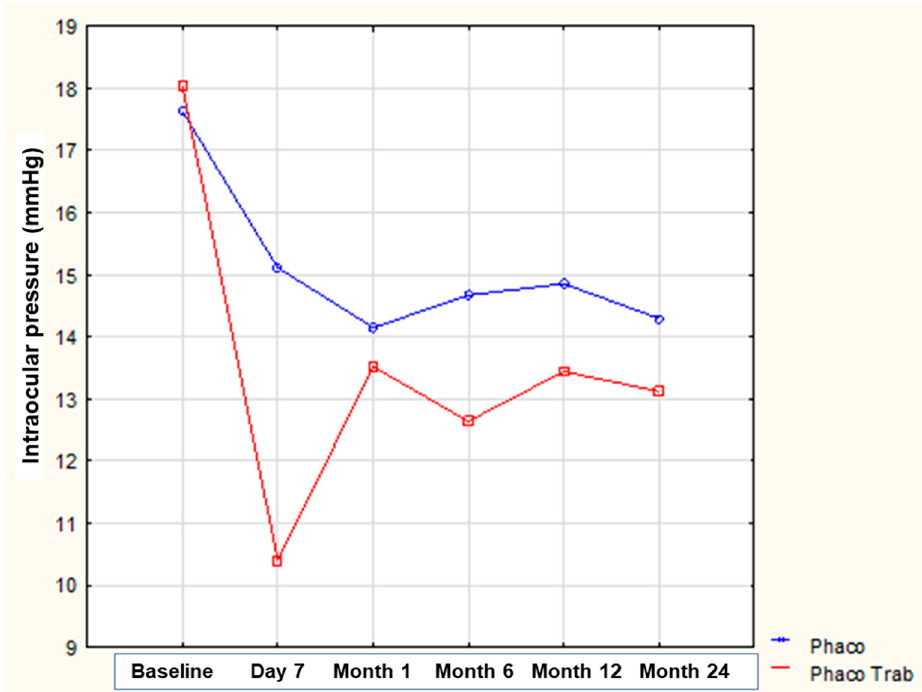
Figure 1. Evolution of intraocular pressure over time between the two groups.